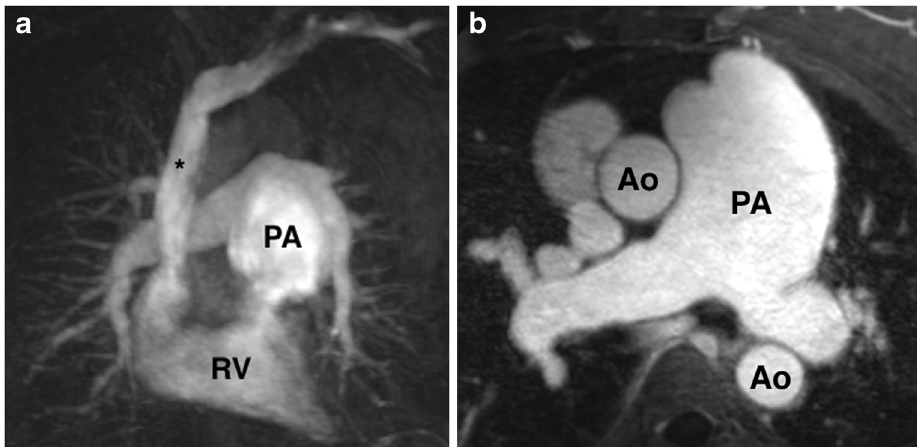
Fig. 17 A pulmonary artery MRA in a 55-year-old woman with pulmo- nary hypertension. Single coronal image from time-resolved pulmonary artery MRA ( a ) and axial T1-weighted fat-saturated post-gadolinium